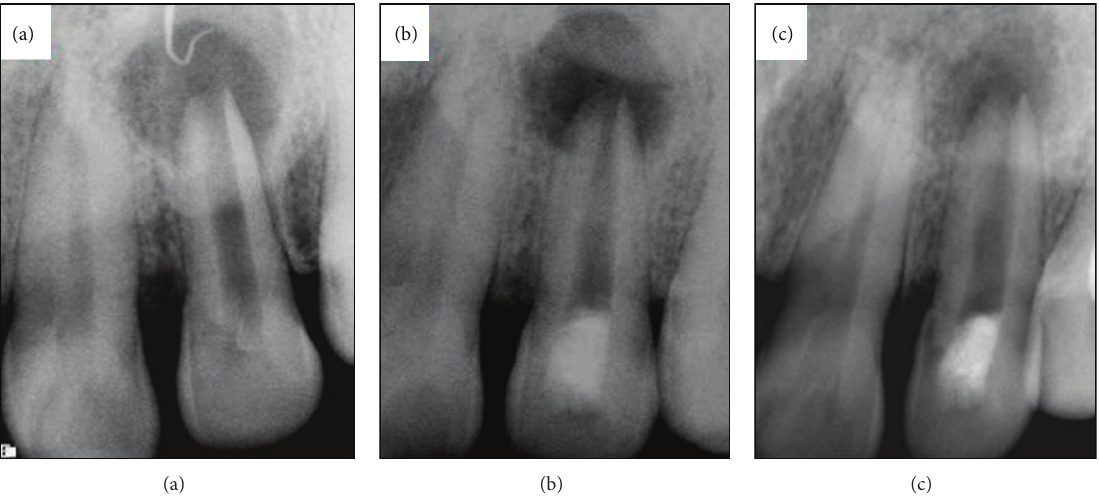
Figure 1: (a) An immature, maxillary right lateral incisor with open apex and large localized, well-defined periapical radiolucency in a 40- year-old male. (b) Six months after revascularization +PRP, apical pathology is reduced and apical narrowing is seen. (c) At 1-year follow-up, normal bony architecture around the entire root is reestablished. Note the narrowing of the apical third of the root